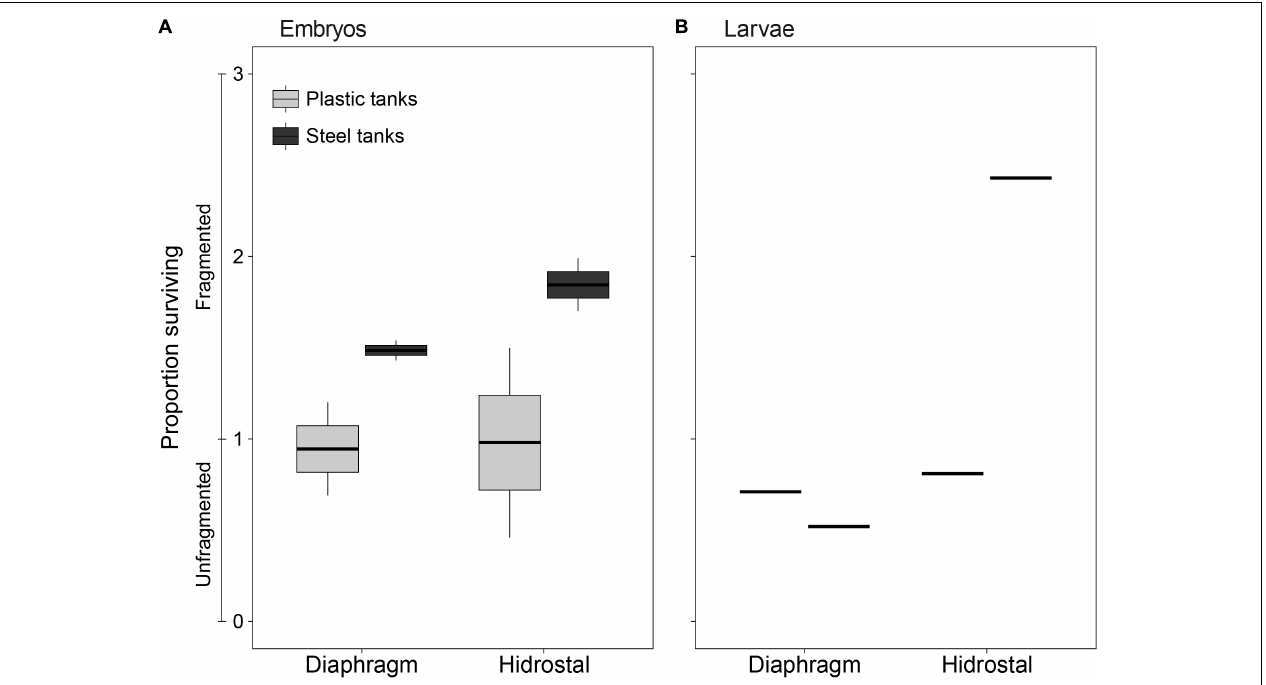
FIGURE 5 | Survival of coral (A) embryos and (B) larvae immediately following pumping by diaphragm and Hidrostal pumps in the plastic and steel tanks. Values ranging from 0 to 1 indicate unfragmented embryo survival, whereas values ranging 1–3 indicate the proportion of fragmented and surviving embryos. The middle line of each boxplot indicates the median value, upper and lower hinges indicate the 75 and 25% quantiles, upper and lower whiskers represent the maximum and minimum observations +1.5 × the inter-quartile range, and individual dots represent outliers ( n = 2 per tank type × pump type for embryos; n = 1 per tank type × pump type for